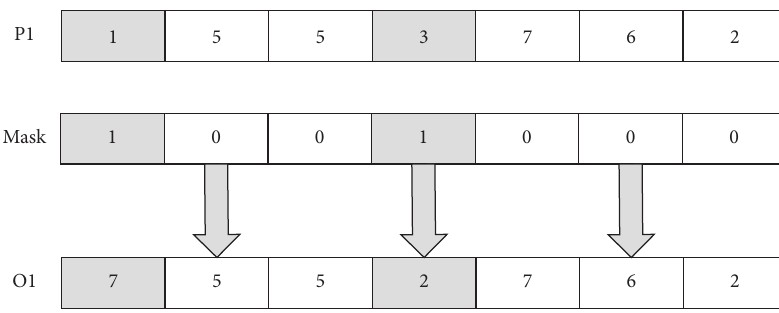
Figure 4: Schematic diagram of high-level chromosome mutations.